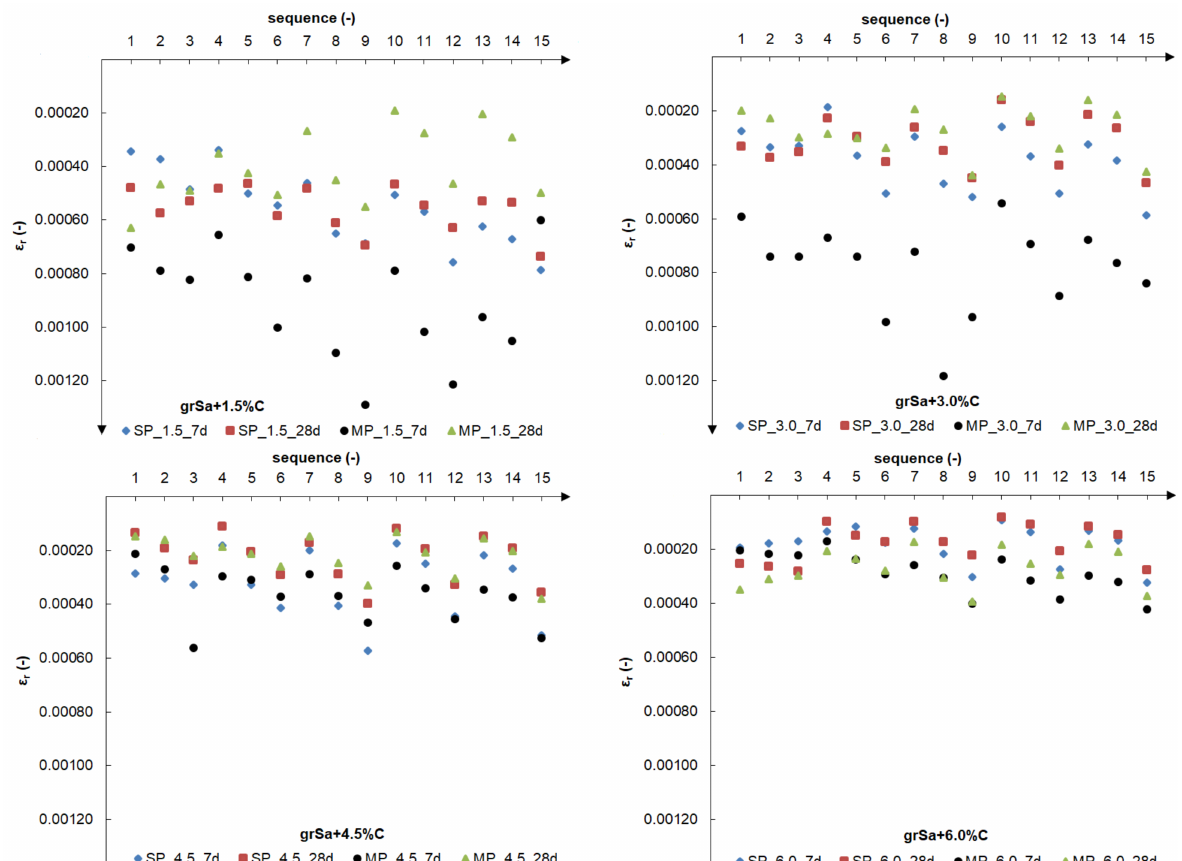
Figure 10. The final values of the relative resilient axial strain in particular 1–15 load sequences for samples compacted by the SP and MP methods after 7 and 28 days of curing for the various cement